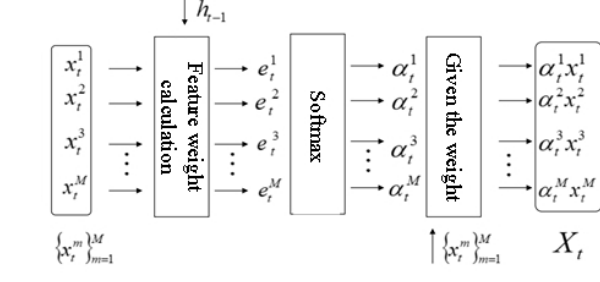
Fig. 4. Feature Attention